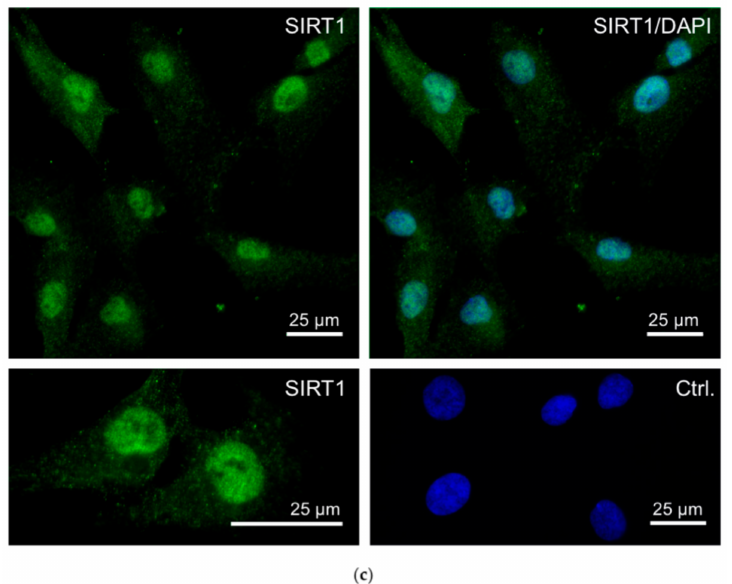
Figure 1. RT-PCR revealed SIRT1 mRNA (single band of 105 bp) in granulosa cell tumor (GCT) samples from four patients ( a ). Non template (-) control was negative (instead of cDNA, H 2 O was used). ( b ) SIRT1 was also detected in KGNs (RT-PCR). ( c ) Micrograph of immunofluorescence staining of SIRT1 in KGN. Upper left: SIRT1 staining (green) was found in the nuclei; upper right micrograph: SIRT1 staining merged with DAPI (blue). Left lower panel: higher magnification of the SIRT1 staining. Left lower panel: control: omission of the first antibody merged with DAPI. Bars represent 25 µ m.